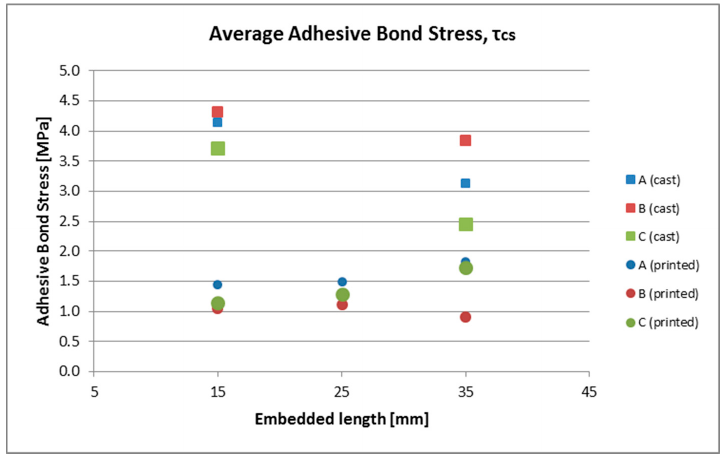
Figure 10. Development of average adhesive bond stress over increasing embedment length.